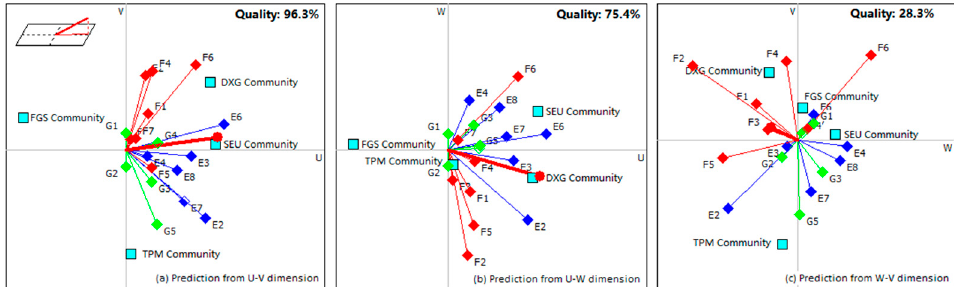
Figure 10. GAIA analysis of community waterlogging-resilience prediction.